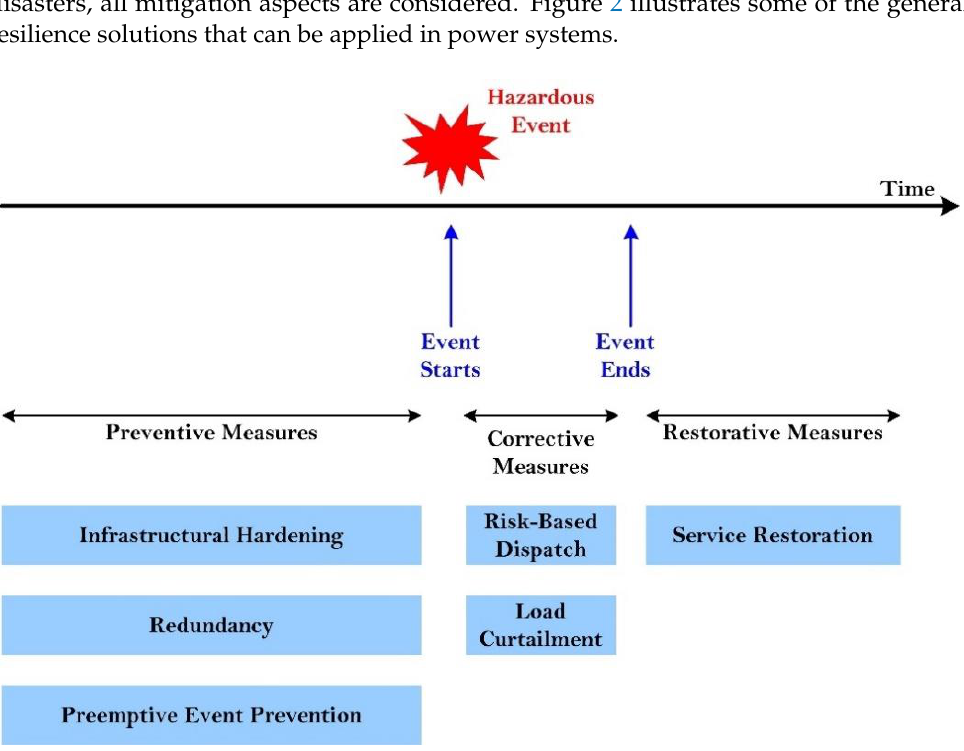
Figure 2. Overview of strategies for power grid resilience.